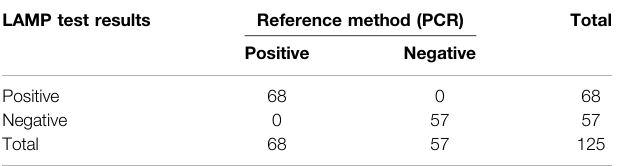
Contingency table displaying LAMP and PCR results targeting the bla KPC gene performed on 125 K. pneumoniae strains; 68 K. pneumoniae strains were bla KPC - positive byboth LAMP and PCR,and 57 strains werenegative byboth LAMPand PCR.